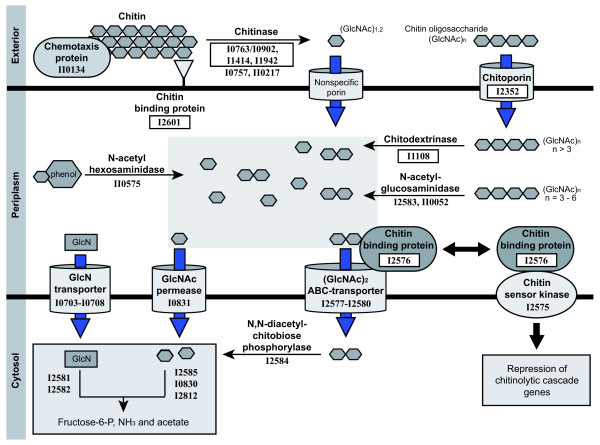
Key steps in the chitinolytic cascade. Functional assignment of A. salmonicida CDSs are derived from bioinformatical analysis, and the abbreviated gene IDs are indicated at each step. Putative non-functional A. salmonicida products are boxed. Initially, a methyl chemotaxis protein (VSAL_II0134) and a chitin binding protein (VSAL_I2601) are involved in sensing and attachment to chitin respectively. Extracellular chitinases (VSAL_I0763/I0902, VSAL_I1414, VSAL_I1942, VSAL_I0757 and VSAL_II0217) partly break down chitin. Chitin oligomers (GlcNAc)n are translocated across the outer membrane by chitoporin (VSAL_I2352), while the transport of monomers and dimers (GlcNAc)1,2 is mediated by unspecific porins. In the periplasm, the chitin oligomers are further degraded to yield (GlcNAc)1,2 by chitodextrinase (VSAL_I1108), N-acetylglucosamidase (VSAL_I2583 and VSAL_II0052) and N-acetylhexosamidase (VSAL_II0575). (GlcNAc)1 are transported across the inner membrane by a permease (VSAL_I0831), while the transport of (GlcNAc)2 are mediated by an ABC-transporter (VSAL_I2577- I2580). Deacetylated monomers (GlcN) are transported into the cytosol by a PTS transporter (VSAL_I0703- I0708). Cytoplasmic enzymes (VSAL_I2581- I2582, VSAL_I2584- I2585, VSAL_I0830 and VSAL_I2812) convert the transport products into fructose-6-P, acetate and ammonia. In the absence of chitin, the perisplasmic chitin oligosaccharide binding protein CBP (VSAL_I2576) binds to the chitin sensor/kinase ChiS (VSAL_I2575) and represses transcription of chitinolytic genes. In presence of chitin, the complex dissociates as CBP binds to the chitin polysaccharides and chitinolytic genes are expressed.